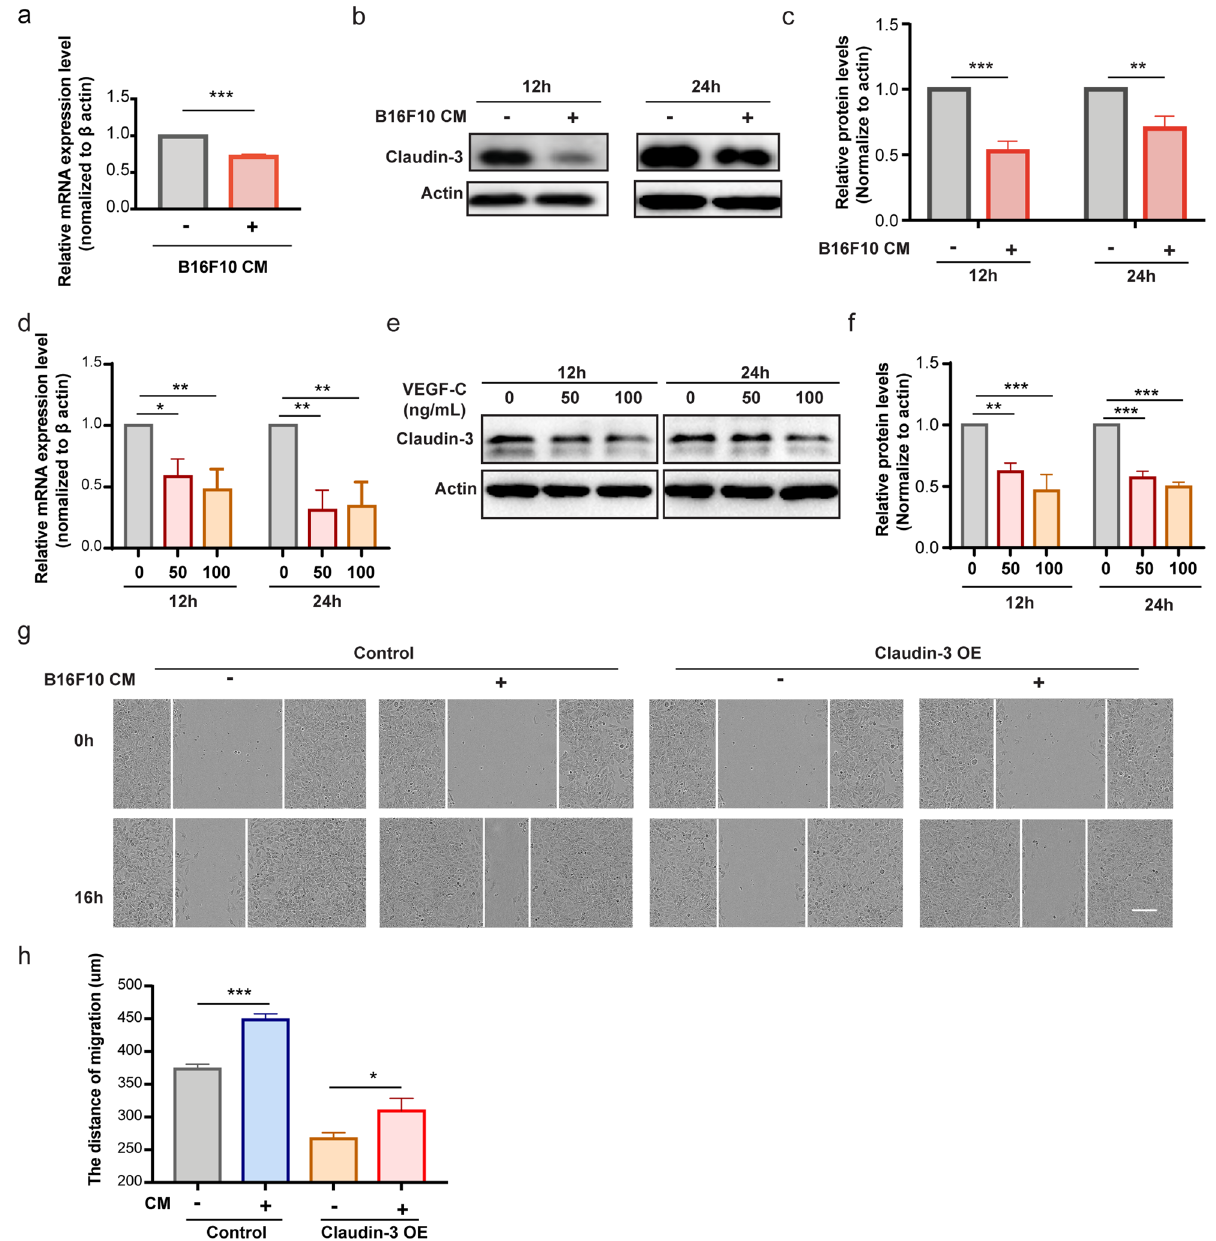
Figure 6. VEGF-C is sufficient to downregulate claudin-3 expression on SVEC4-10 cells. ( a ) SVEC4-10 cells were co-cultured with conditional medium (CM) from B16F10 cells for the indicated time. RT-PCR analysis was used to examine the mRNA expression of claudin-3. (*** p < 0.001) (n = 3 per group) ( b ) Western blot analysis indicated the protein expression level of claudin-3 protein in SVEC4-10 cell. ( c ) Quantitative analysis for western blot results. (** p < 0.01, *** p < 0.001) (n = 3 per group) ( d ) SVEC4-10 cells were treated with 0 ng/mL, 50 ng/mL or 100 ng/mL VEGF-C for 12 h or 24 h. RT-PCR analysis was used to examine the mRNA expression of claudin-3. (* p < 0.05, ** p < 0.01) (n = 3 per group) ( e ) Western blot analysis indicated the protein expression level of claudin-3 protein in SVEC4-10 cell. ( f ) Quantitative analysis for western blot results. (** p <